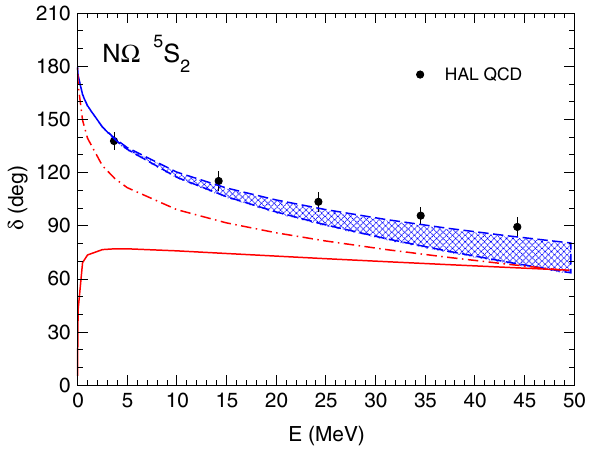
Fig. 6 N Ω 5 S 2 phase shift. The result of the HAL QCD collaboration is taken from Ref. [20]. Results of a fit to the lattice simulation is shown by a hatched band, corresponding to cut-off variations between 500 and 700 MeV. The corresponding results for physical masses are shown by solid (700 MeV) and dash-dotted (500 MeV) lines Table 9, which can be fixed by a fit to the lattice